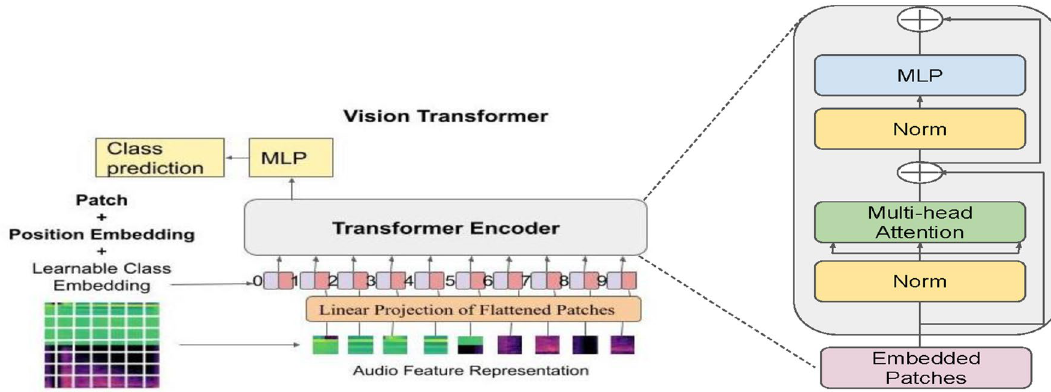
Figure 2. The figure shows the division of an image into patches of size 32 × 32 . The outputs from the linear projection layer is combined with positional embedding and a learnable class embedding for classification. The above diagram of the transformer encoder was derived from the work of Vaswani et al. 43 techniques where Short Time Fourier Transform (STFT), was used to get the spectrogram of an audio signal. Once the spectrogram was generated, then kNN and random subspaces were used to classify them. The study found that STFT gives better accuracy than CWT. Mares and Blackburn have focused on reducing gun violence by providing an evaluation for St. Louis’ Acoustic Gunshot Detection System’s (AGDS) 48 . They have done a quasi-experimental longitudinal panel study by conducting various experiments over time. The experimental study shows a substantial increase (80%) in gunshot responses by the system. Thus, from the overall study and literature survey, it has been observed that gunshot detection plays an important role in the forensic, health sec- tor, and security, which motivated us to work in this area.